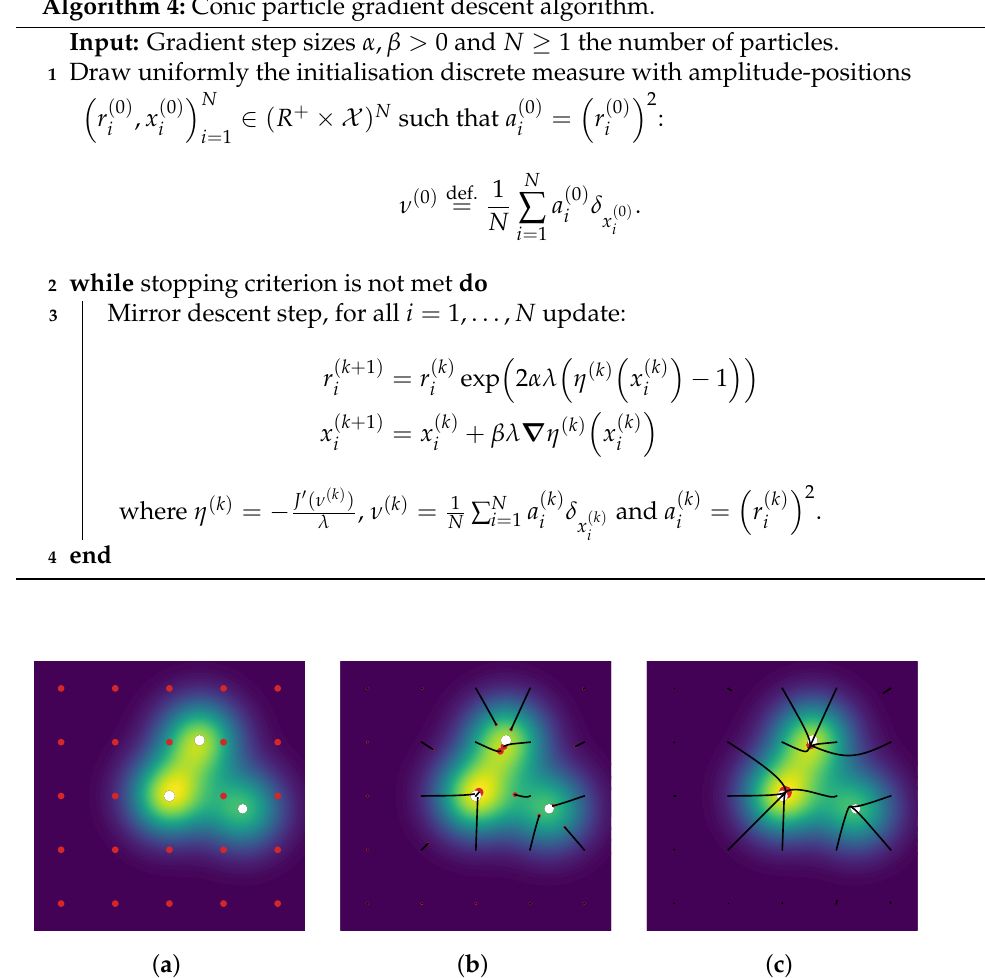
Algorithm 4: Conic particle gradient descent algorithm.